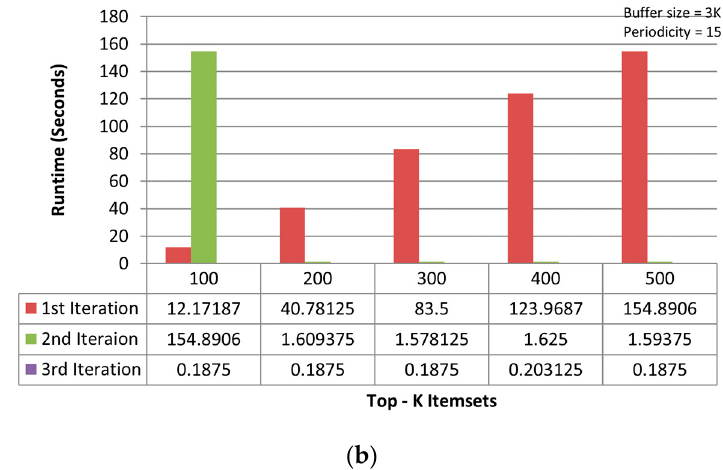
Figure 6. ( a ) Results of three iterations of TKIFRPM on the mushroom dataset. ( b ) Results of three iterations of MTKPP on the mushroom dataset.